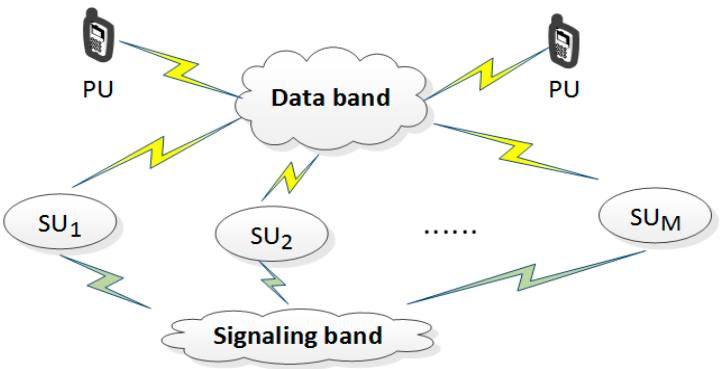
Figure 2. The cognitive wireless communication system with an additional signaling channel (CSCS-ASC) system model.